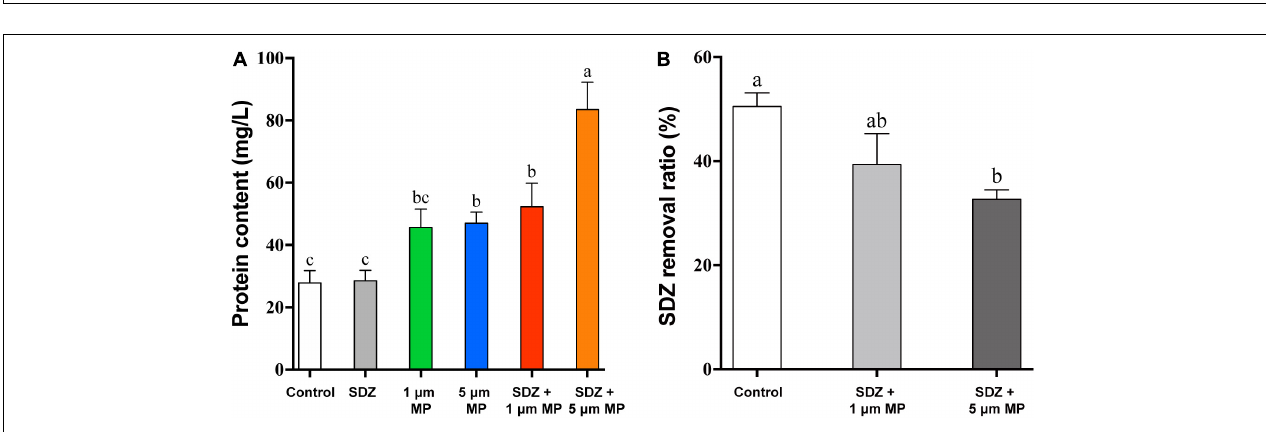
FIGURE 5 | The chlorophyll contents (A) and photochemical efficiency (B) of C. reinhardtii exposed to PS-MPs (1 and 5 µ m) and/or SDZ (50 mg l − 1 ). Data are shown as means ± SEM of three replicates and an asterisk note for significant difference between treatments and the control group ( p < 0.05).